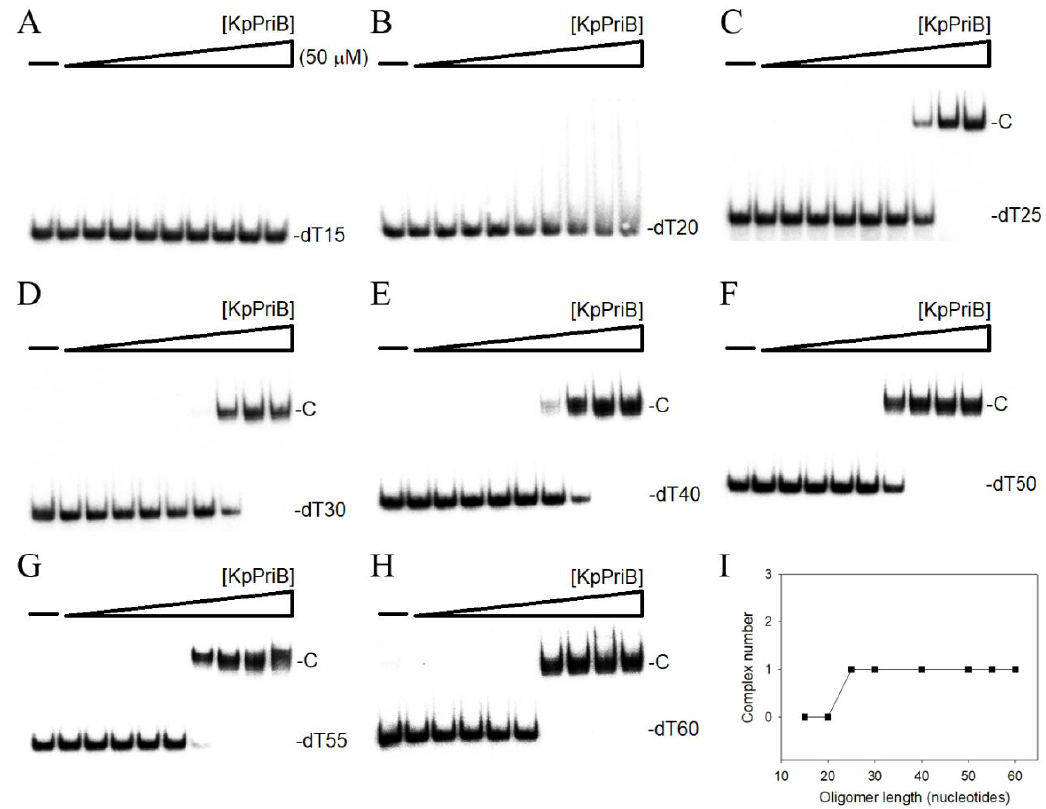
Figure 6. EMSA of KpPriB. Protein (0–50 µ M) was incubated at 25 ◦ C for 30 min with 1.7 nM of ( A ) dT15, ( B ) dT20, ( C ) dT25, ( D ) dT30, ( E ) dT40, ( F ) dT50, ( G ) dT55, or ( H ) dT60 in a total volume of 10 µ L in 20 mM Tris–HCl (pH 8.0) and 100 mM NaCl. ( I ) Summary of the complex number of KpPriB. Complex number of KpPriB as a function of the length of the ssDNA determined using EMSA.